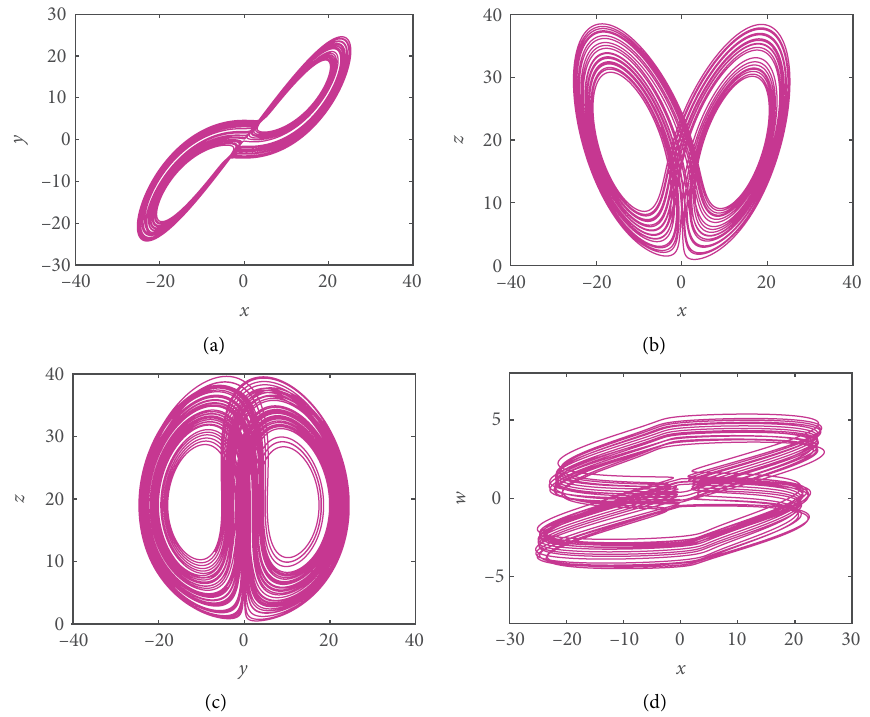
Figure 6: Hyperchaotic circuit by introducing memristor feedback.